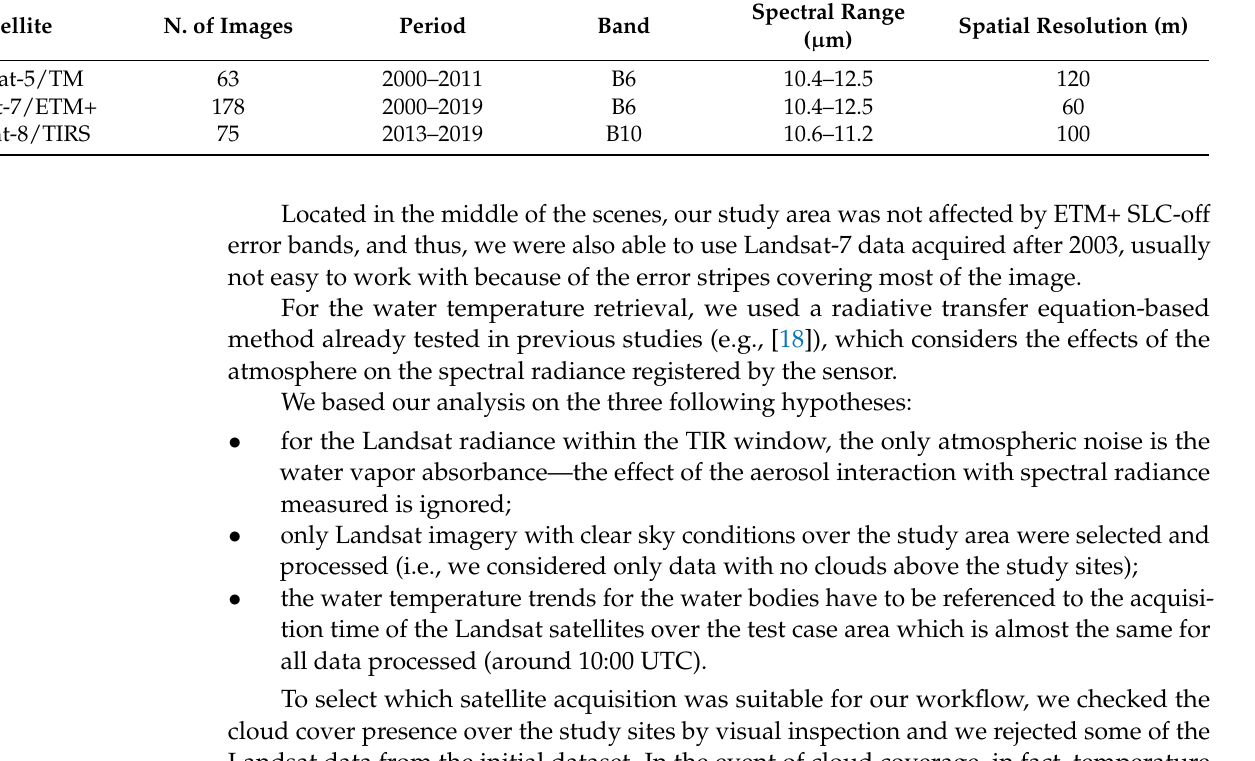
Table 2. Summary of characteristics of the dataset (2000–2019) created for the scope of the work. Satellite N. of